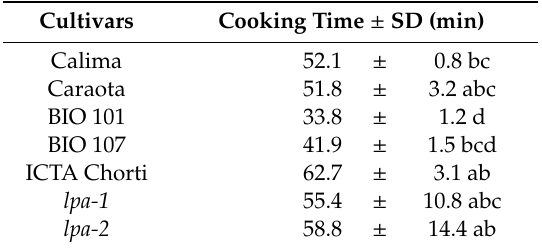
Table 3. Cooking times of the seven di ff erent bean varieties using the Mattson Cooker, soaked for 16 h at room